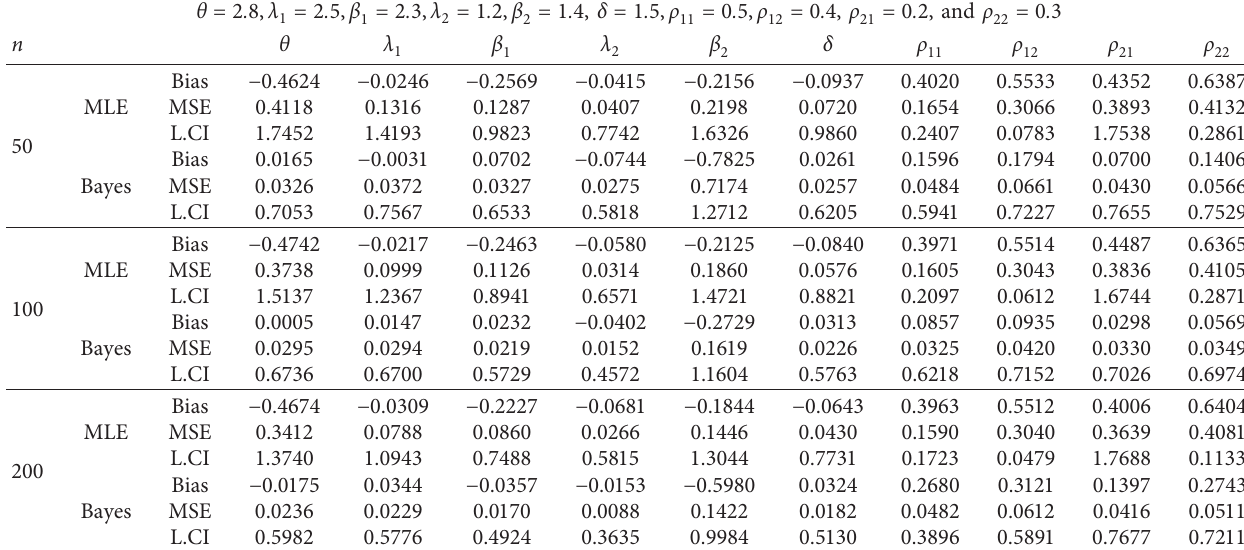
Table 4: MLE and Bayesian estimation with different sample sizes in the dependent case (Case